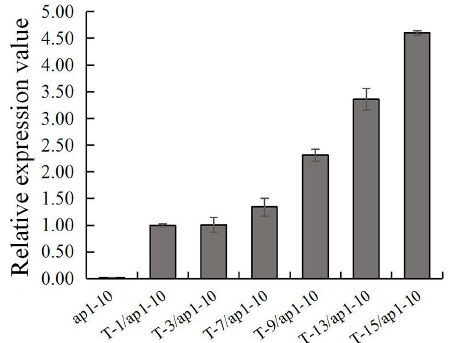
Figure 7. Expression of FaesAP1 in transgenic Arabidopsis ap1-10 mutant confirmed by qPCR. ap1-10 : Arabidopsis ap1-10 mutant; ( T-1 / ap1-10, T-3 / ap1-10 ) T-1 and T-3 independent lines of 35S:: FaesAP1